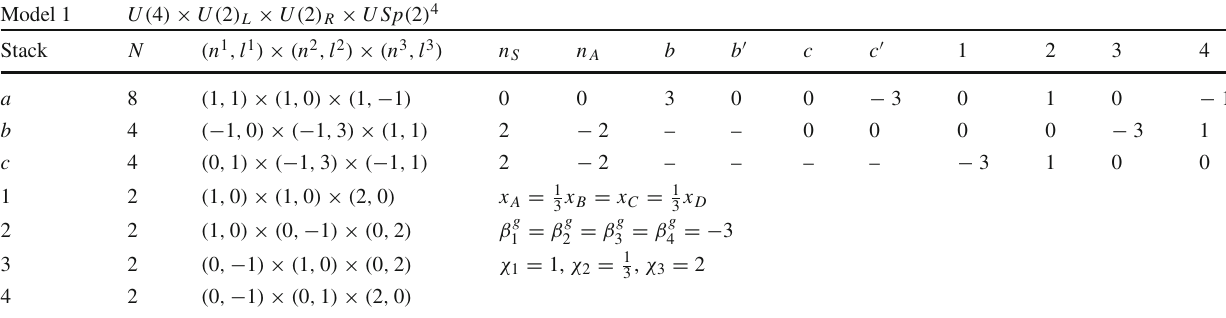
(cid:6) = g 2 = ( 5 ) = 4 2 g 2 c b Y 3